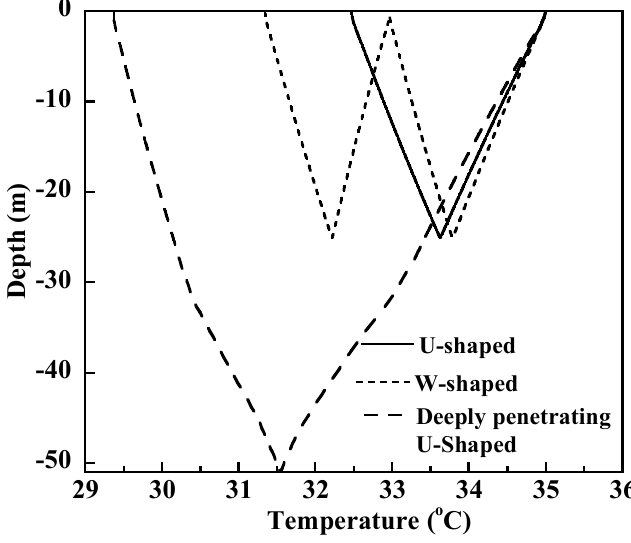
Figure 5. Temperature variation along the tube after 50 h of cooling: comparison between deeply penetrating U-shaped configuration versus U-shaped and W-shaped configurations. Table 6. Comparison of thermal performance for three different tube configurations. Tube Configuration